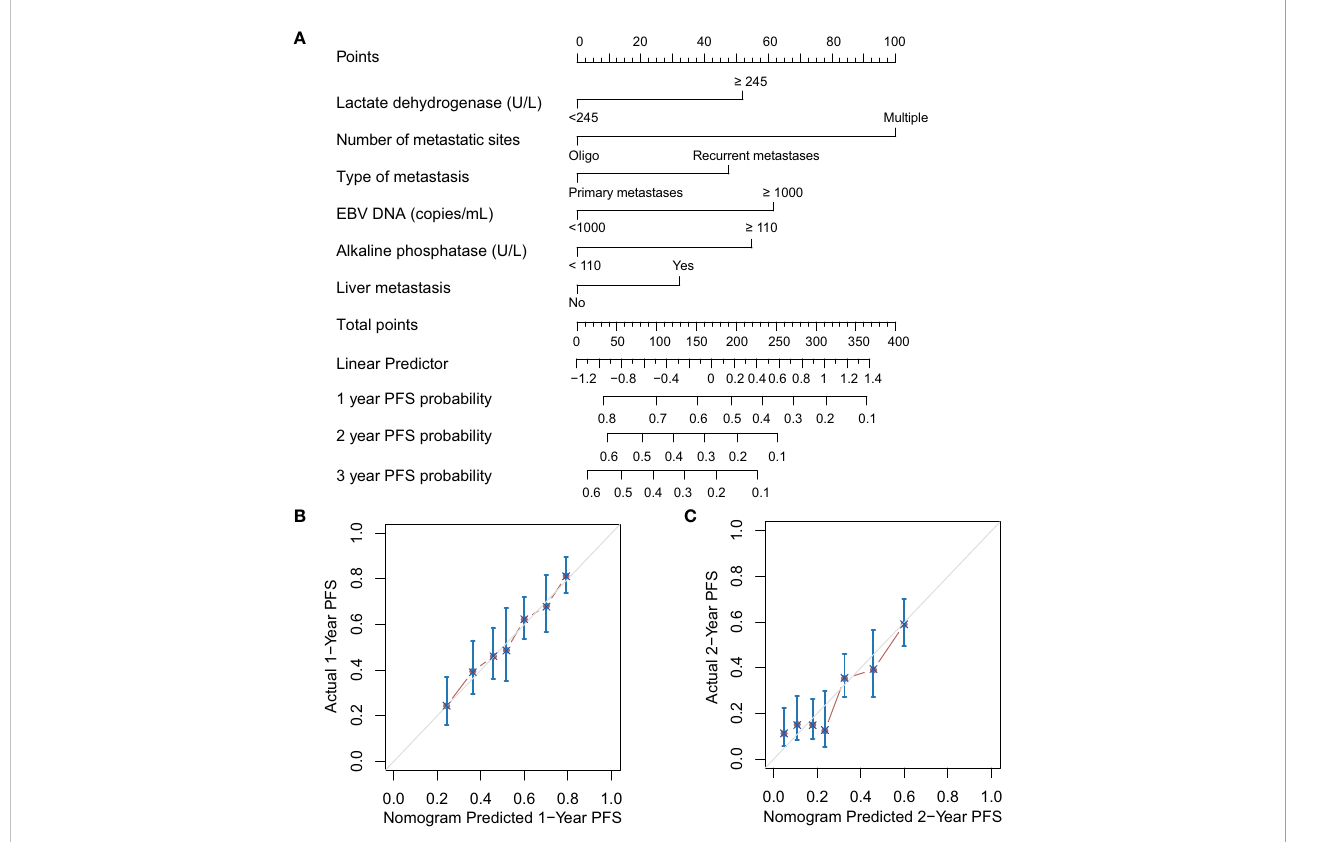
FIGURE 2 Prognostic nomograms (A) and calibration plots of survival probabilities at 1 years (B) and 2 years (C) in patients with metastatic NPC. EBV, Epstein – Barr virus; PFS, progression-free survival.